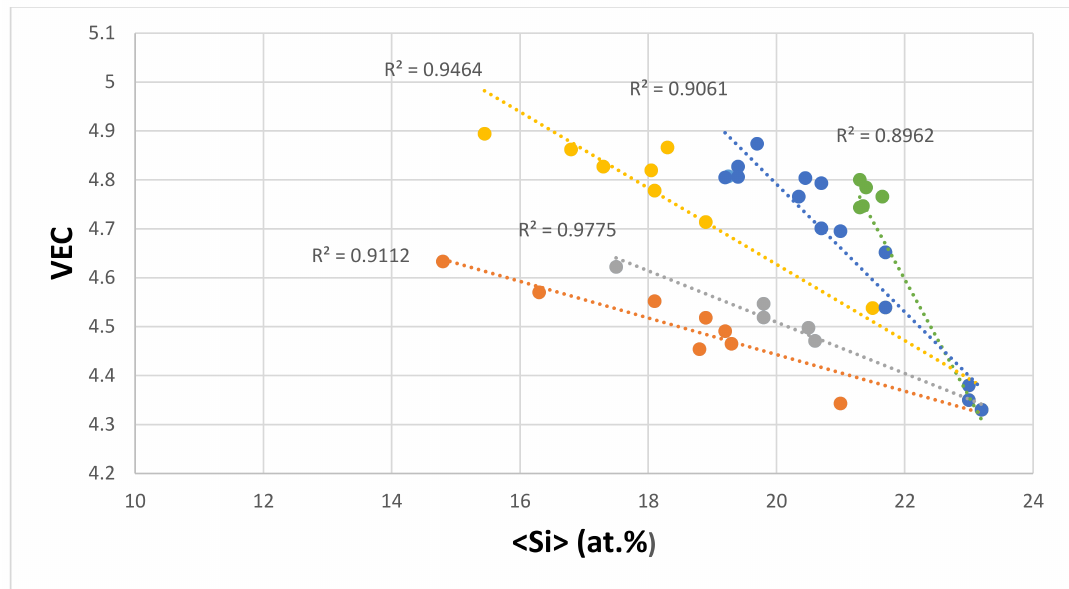
Figure 14. VEC versus <Si> map for eutectics with Nb ss and Nb 5 Si 3 in Nb-silicide based alloys, series a (R 2 = 0.9464) with alloying element additions of Al, Cr, Fe, Ge, Hf, Mo, Si, Sn, Ti, V, and W; series b (R 2 = 0.9112) with alloying element additions of Al, Cr, Fe, Ge, Hf, Si, Sn, Ti, and Y; series c (R 2 = 0.9061) with alloying element additions of Al, Ge, Hf, Mo, Si, Sn, Ta, Ti, V, W, and Zr; series d (R 2 = 0.8962) with alloying element additions of Al, Cr, Ge, Hf, Mo, Si, Sn, Ti, and W; series e (R 2 = 0.9775) with alloying element additions of Al, Cr, Hf, Si, Sn, and